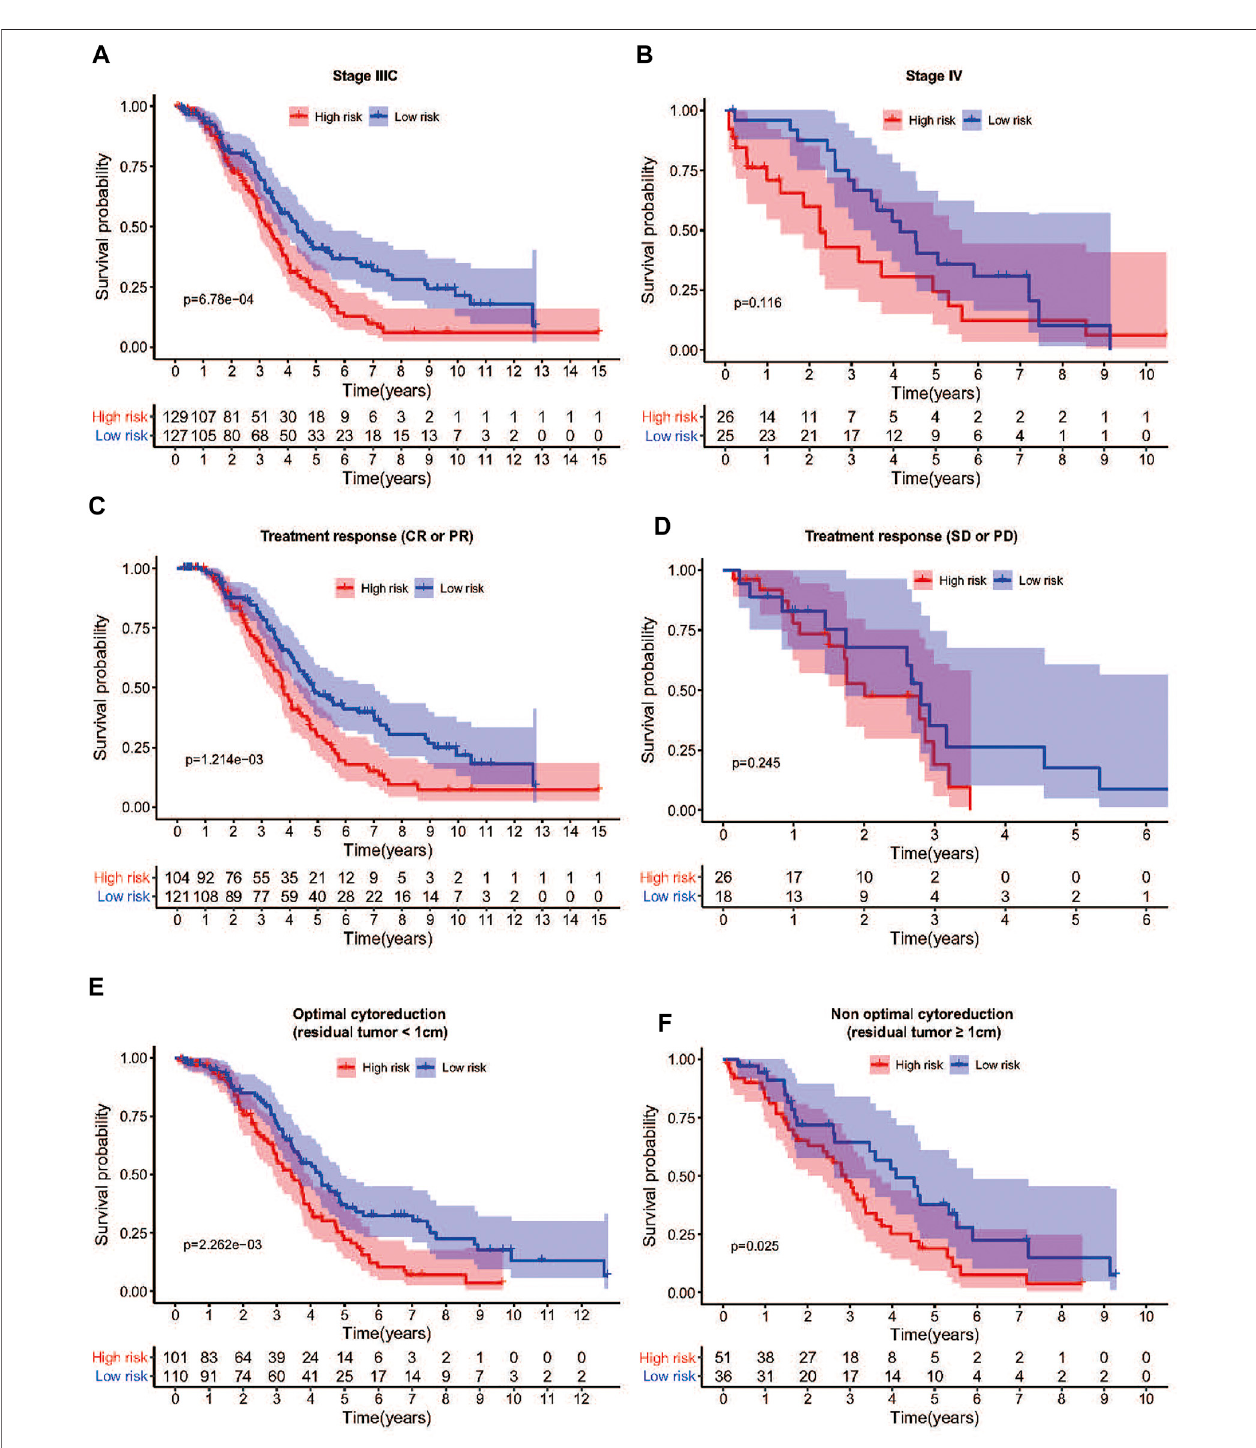
FIGURE6| Differences in survivalbetween high-and low-riskgroups strati fi edbyclinicopathological factors inTCGAcohort. (A) TheOSwasremarkably worse in thehigh-riskgroupthanthatoflow-riskgroupinFIGOstageIIICpatients. (B) Thelow-riskgroupshowedabetterprognosistrendthanthehigh-riskgroupinFIGOstage IV patients. (C) Among patients who achieved CR or PR after treatment, the OS of the high-risk group was also shorter than that of the low-risk group. (D) Among patients who achieved SD or PD after treatment, there was no signi fi cant difference in OS between the high-risk group and the low-risk group. (E) The OS was remarkablyworseinthehigh-riskgroupthanthatoflow-riskgroupamongpatientswithoptimalcytoreductivesurgery. (F) TheOSwasremarkablyworseinthehigh-risk group than that of low-risk group among patients with non-optimal cytoreductive surgery. Abbreviation: OS: Overall survival; CR: Complete remission; PR: Partial remission; SD: Stable disease; PD: Progressive disease.